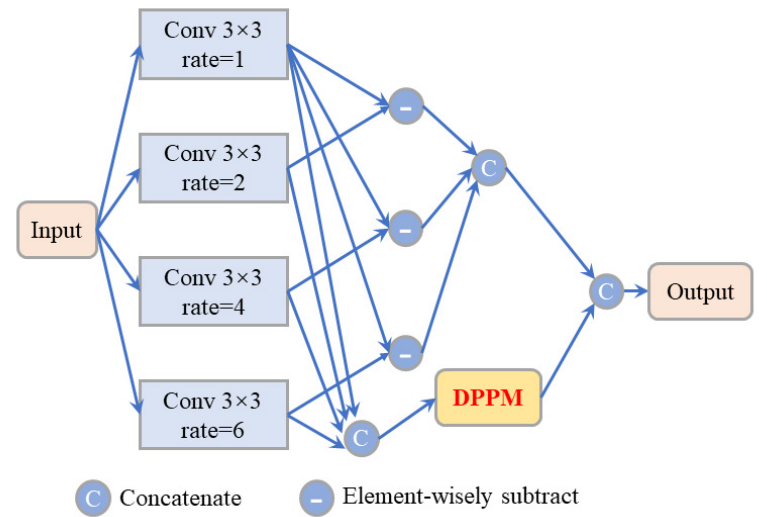
Figure 3. Illustration of Multi-scale Context Contrasted Local Feature module.